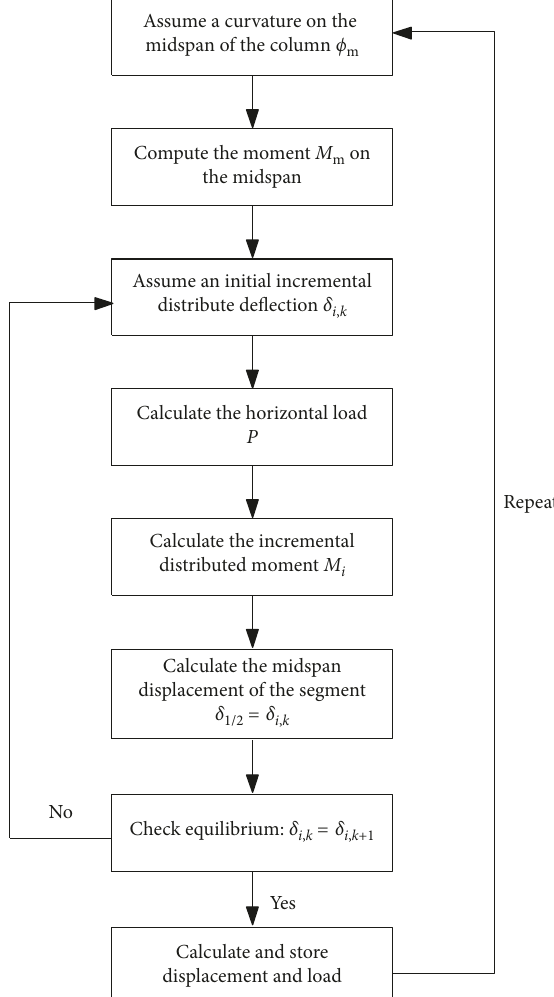
Figure 4: Flow chart of the numerical procedure for calculating the resistance